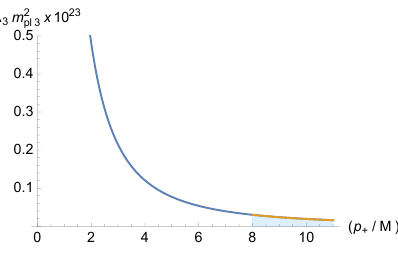
Figure 7. The cosmological constant plotted against p p > 8% M